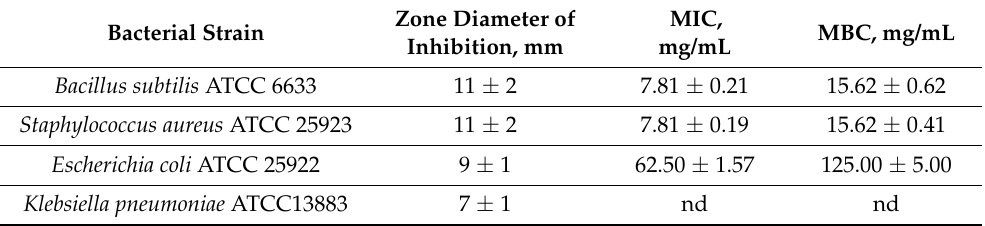
Table 3. The antimicrobial activity, minimum inhibitory concentration (MIC) and minimum bacteri- cidal concentration (MBC) of GME against bacterial strains (the results are expressed as means ± standard deviations of three experiments). Zone Diameter Bacterial Strain